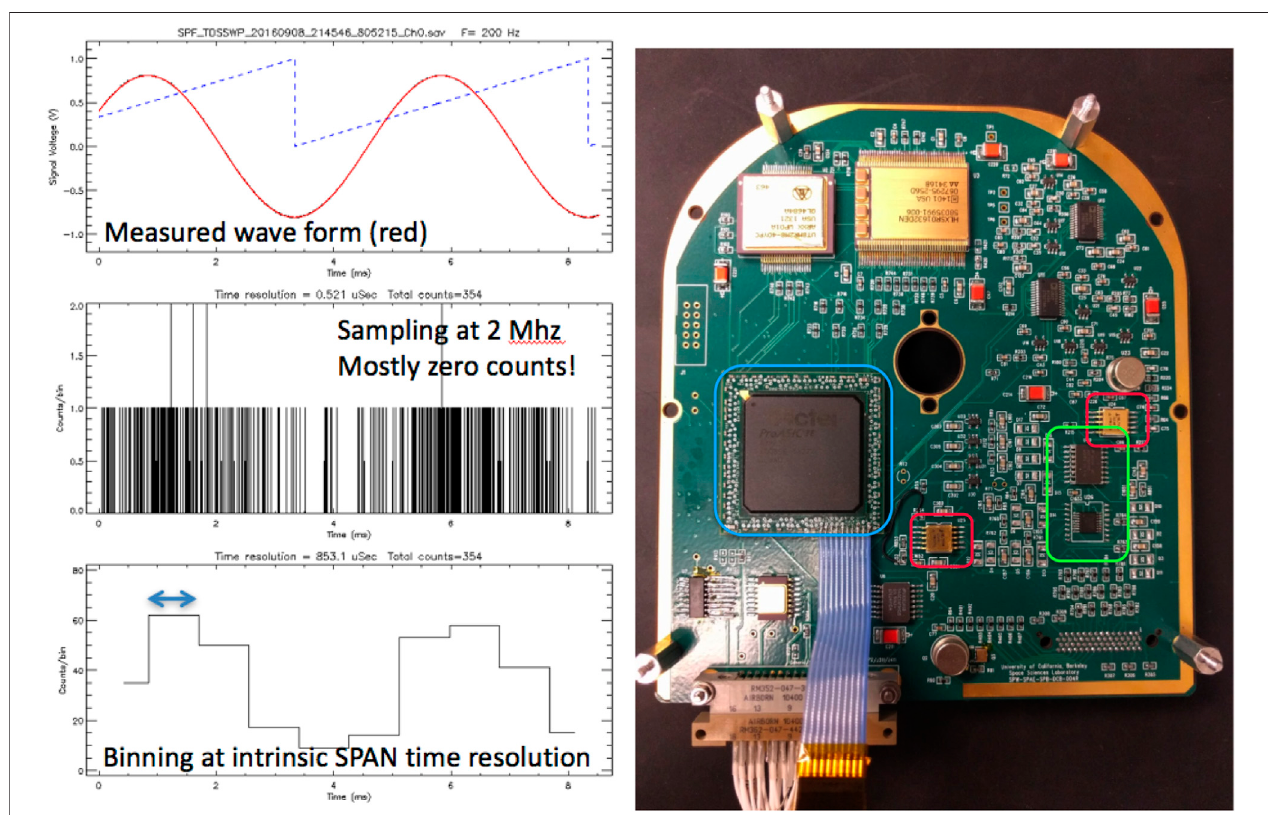
FIGURE 6 | (Left top) Waveform of the oscillating voltage applied to modulate the ion source (red) at f = 200 Hz frequency. (Left middle) Particles counted within 0.5 μ s time bins, showing mostly 0 or 1 counts, indicating Poisson counting statistics. (Left bottom) At the SPAN phase-space bin time resolution of δ t = 0.85 ms, the modulation in the number of detected ions at the f = 200 Hz frequency. (Right) Photograph of the SPAN-E digital electronics